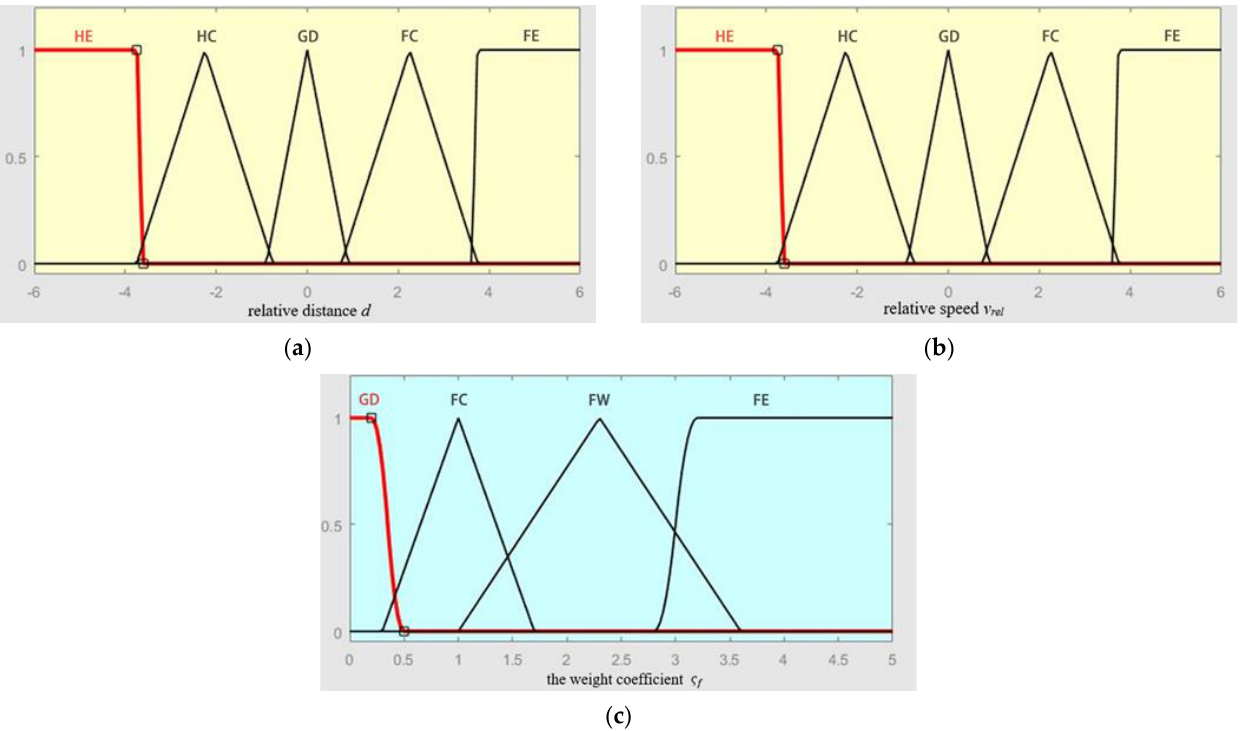
Figure 2. Membership function of each variable: ( a ) relative distance d ; ( b ) relative speed v rel ; ( c ) the weight coefficient c f .